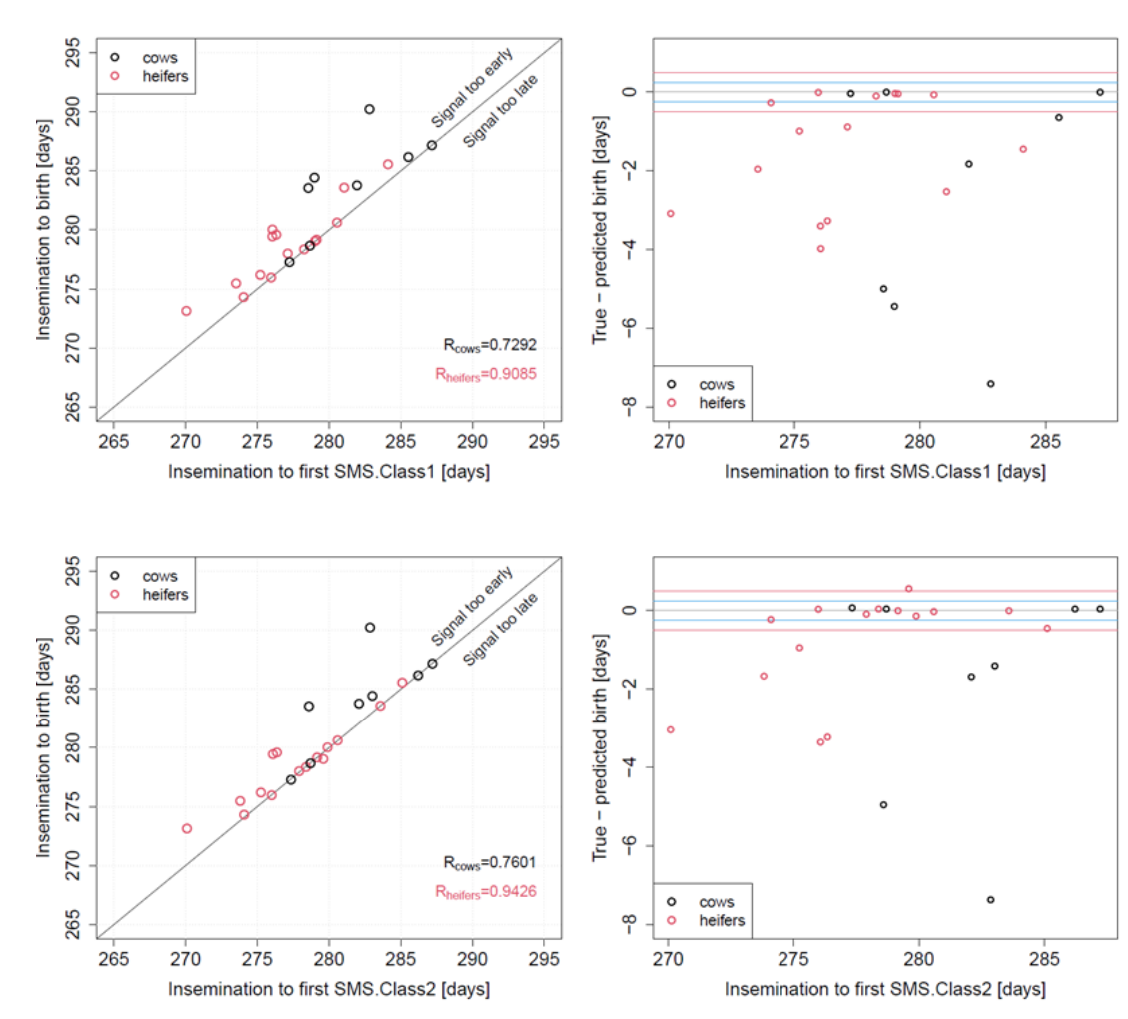
Figure 2. ( Left ): correlation between duration from insemination to SMS1 ( top ; enhanced tail activity registered over one hour) and SMS2 ( bottom ; high tail activity continued during the consecutive hour) emitted by the remote calving sensor Moocall attached to the tail of late pregnant animals, and the true duration from insemination to birth. ( Right ): difference between true and predicted birth date using SMS1 ( top ) or SMS2 ( bottom ).